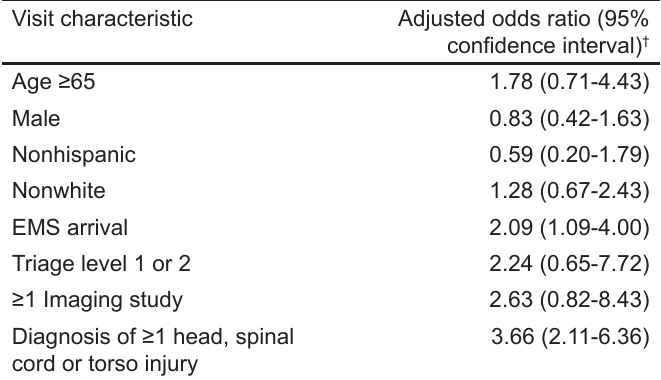
Table 3. Multivariate model of factors associated with hospitalization of MVC patients treated in emergency departments by age, United States